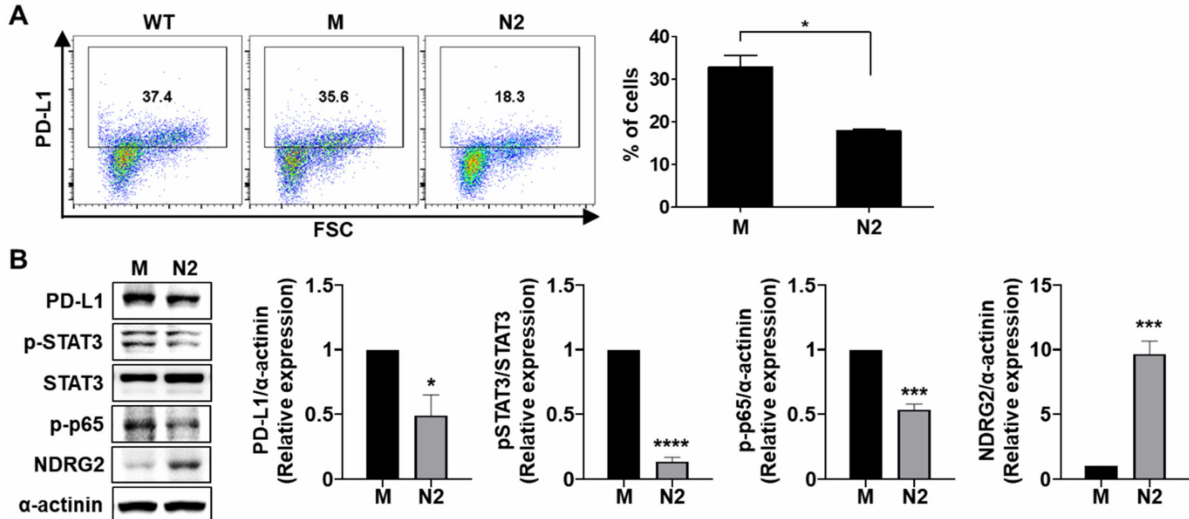
Figure 3. NDRG2 overexpression reduces the expression of PD-L1, p-STAT3, and p-p65. ( A ) PD-L1 expression in 4T1-wild- type, -mock (M), and -NDRG2 (N2) cells was measured by flow cytometry. ( B ) The expression levels of NDRG2, p-STAT3, and p-p65 (p-NF- κ B) in 4T1-mock and 4T1-NDRG2 cells were examined by Western blot analysis. All experiments were independently repeated at least 3 times. * p < 0.05, *** p < 0.001, and **** p < 0.0001. The uncropped blots and molecular weight markers are shown in Supplementary